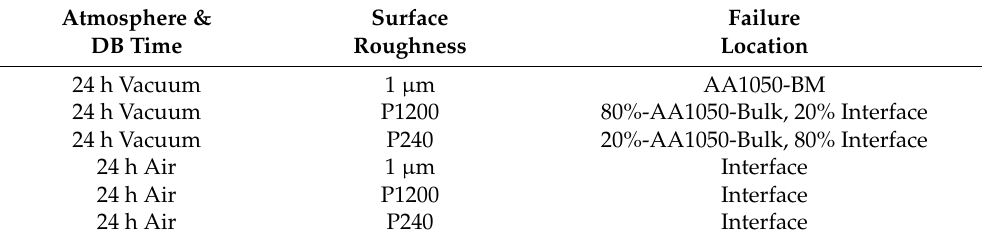
Figure 14. Interface temperature and pressure at different locations (A – D) as a function of time dur- ing the bonding process.